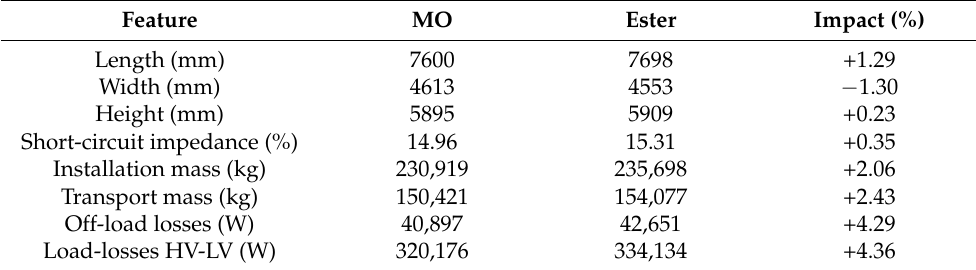
Table 7. Case 3—transformers’ final